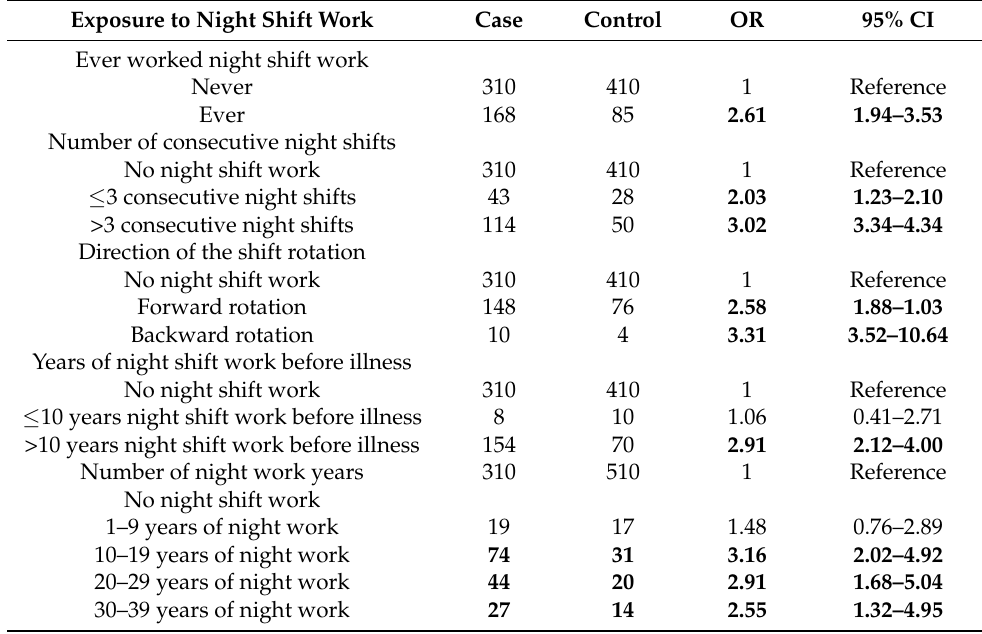
Table 2. The crude odds ratios of breast cancer in night workers (taking into account the intensity of night work) compared to non-night workers.